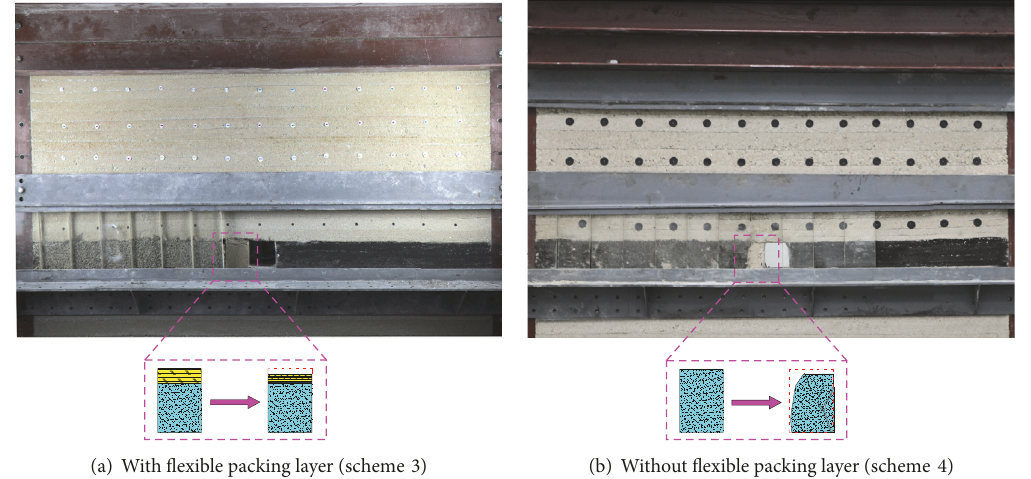
Figure 13: Support effect of gob-backfilled